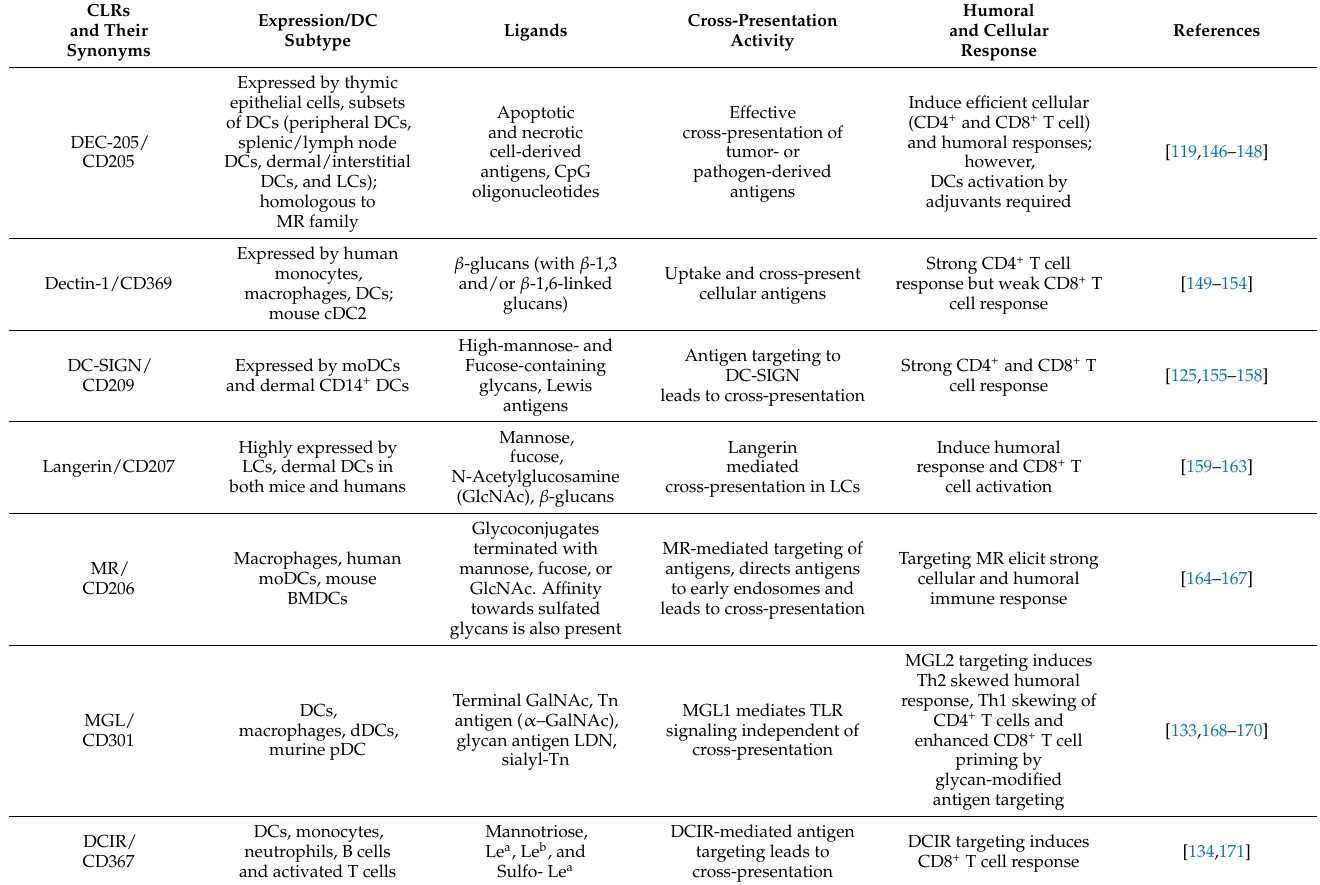
Table 2. Comparing various CLRs present on DCs, their expression pattern, ligand specificity, involvement in cross-presentation of antigens, and immunological (humoral and cellular)